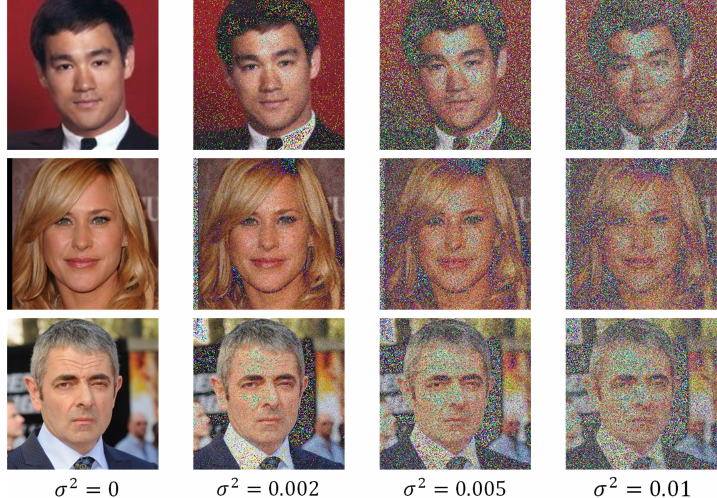
Figure 1. The sample testing images which were injected with different intensity of Gaussian noise.